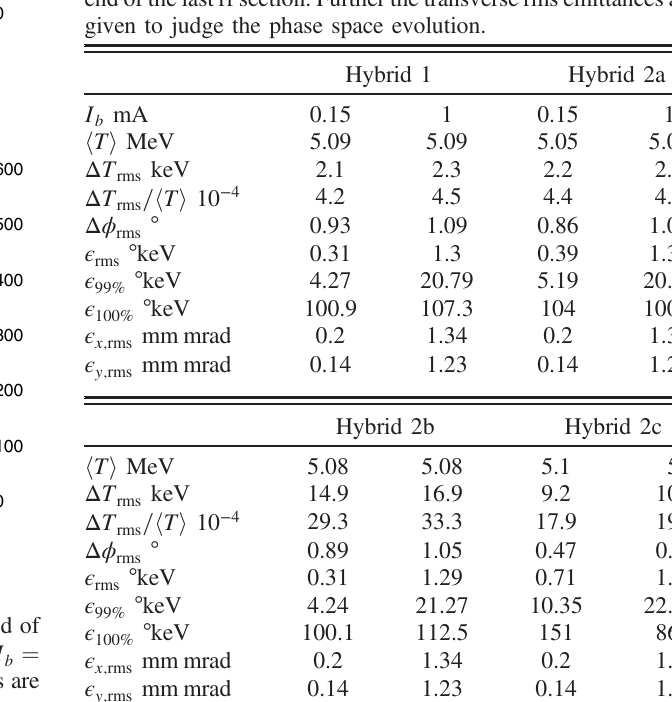
¼ 150 μ A (Fig. 7a) and I b